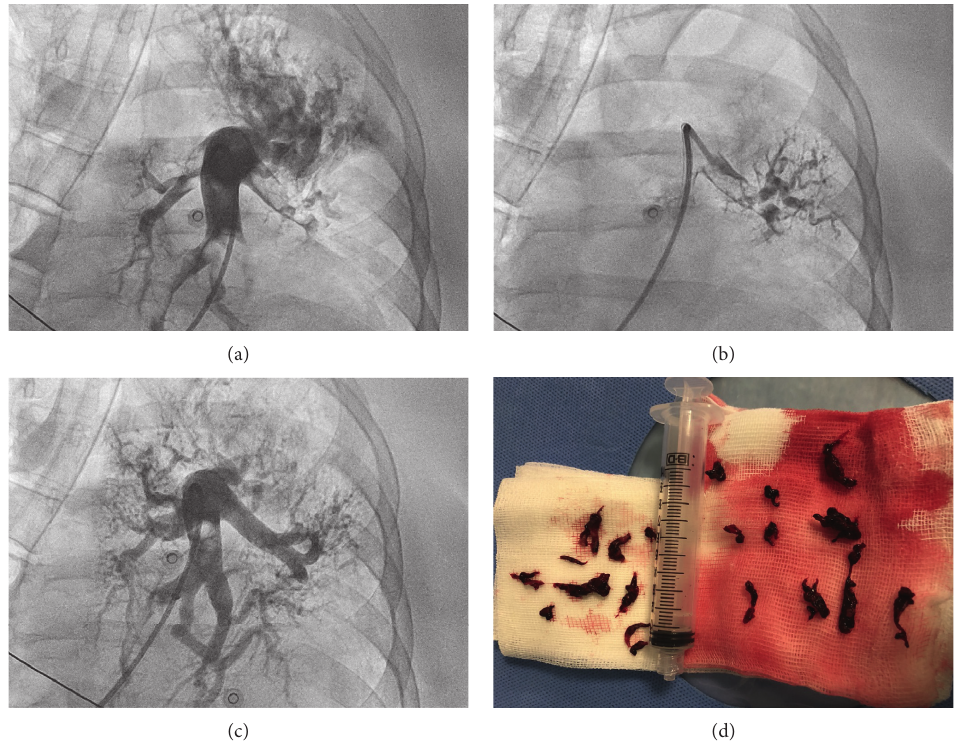
Figure 3: The CDT procedure. CDT � catheter-directed mechanical aspiration thrombectomy. (a) An initial angiogram illustrating the thrombus location in the left lobar arteries. (b) The Indigo catheter is placed in the target clots. (c) An angiogram after the CDT revealing marked improvement in the flow to the inferior lobe of the left lung. (d) An image of the removed